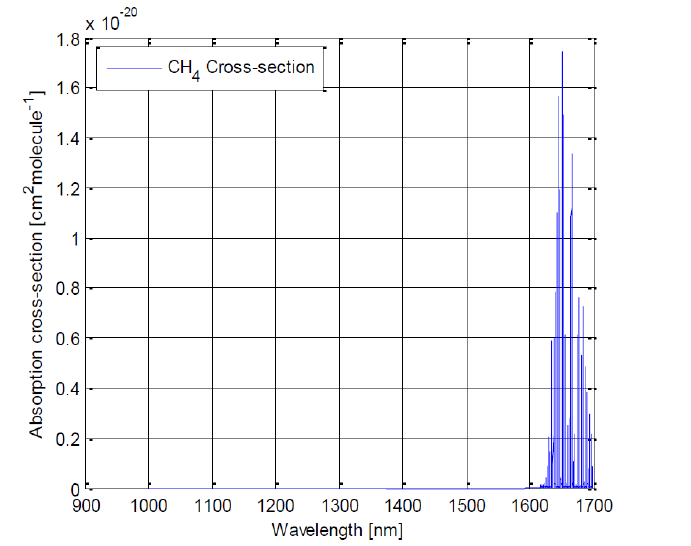
Figure 2. Absorption cross-section for CO 2 between 900 and 1700 nm. Key spectral lines are at 1240, 1420, 1570 and 1610 nm [36].